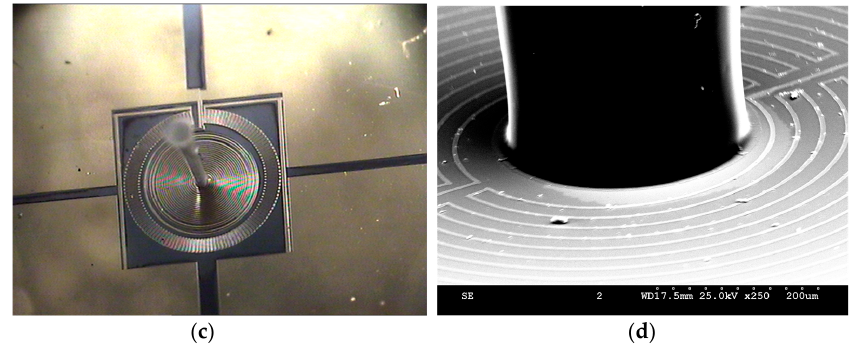
Figure 6. SU-8 hair cell sensor: ( a ) Full bridge on 2 μ m silicon membrane showing two radial and two spiral resistors; ( b ) Half bridge on 2 μ m silicon membrane showing one radial and one spiral resistor; ( c ) SU-8 hair cell fabricated at the center of the strain gauges; ( d ) A SEM image showing the root of the SU-8 hair cell.